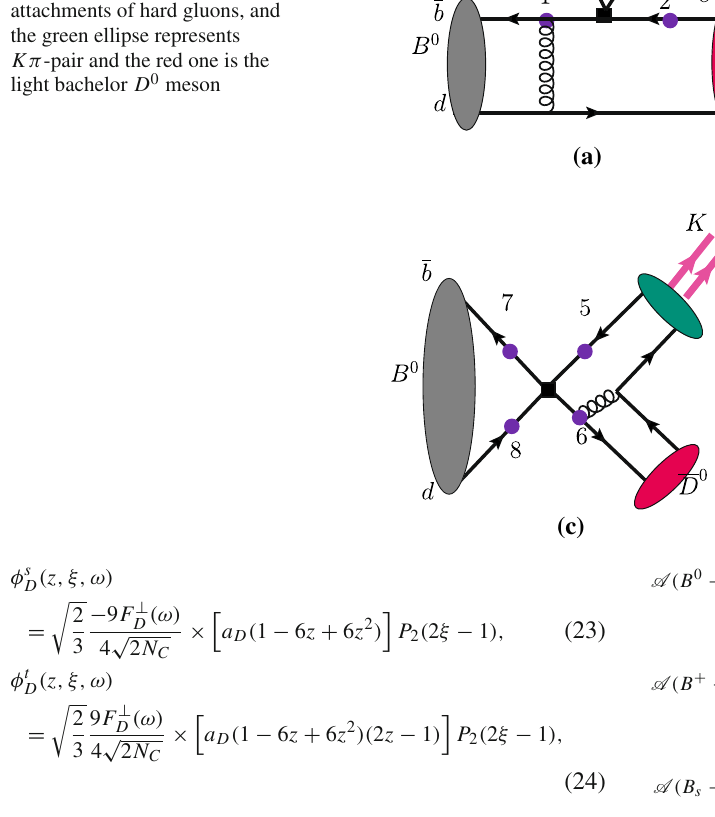
Fig. 1 Typical Feynman diagrams for the quasi-two-body decay B 0 → D 0 ( R → ) K π in PQCD, where the black squares stand for the weak vertices, large (purple) spots on the quark lines denote possible attachments of hard gluons, and the green ellipse represents K π -pair and the red one is the light bachelor D 0